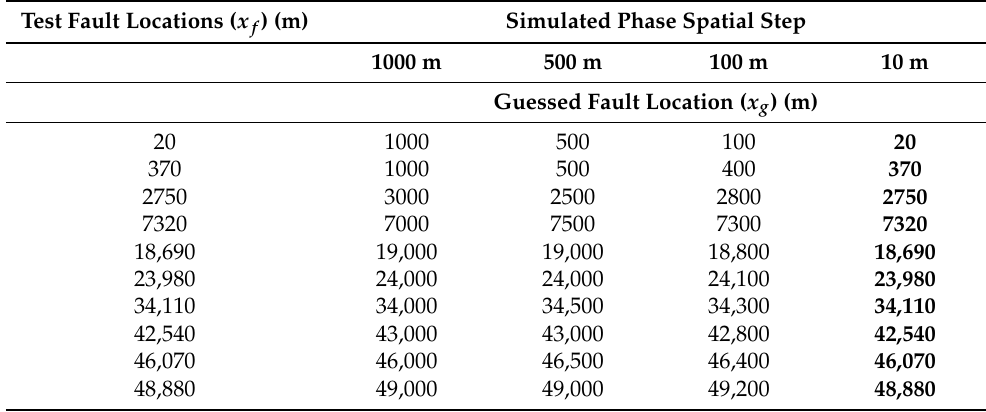
Figure 17. Correlation estimator: considering different spatial steps in the fault estimation stage. The test fault location is 8.25 km. Table 4. Correlation estimator: fault location accuracy for different spatial steps in the fault estima- tion